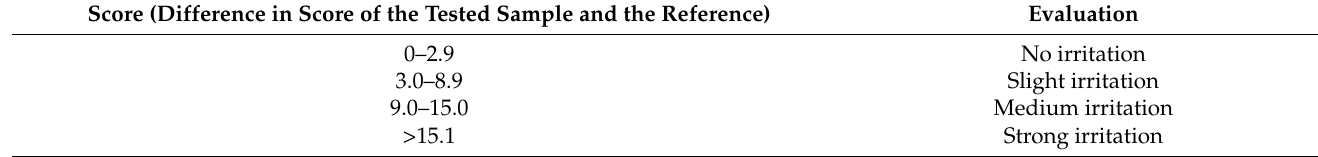
Table 2. The evaluation score for the general-response estimation of the tested implants. Score (Difference in Score of the Tested